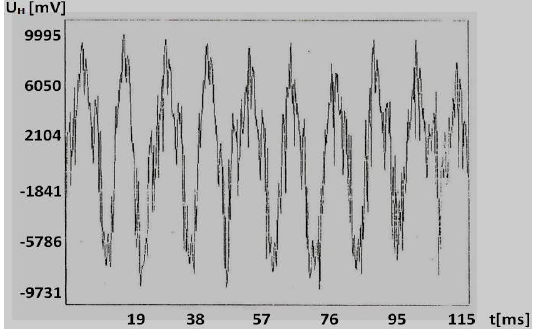
Figure 18. Hall voltage versus time in case of brush wear, Hall sensors fixed on the stator, loaded starter. The waveforms of induction distribution measured by Hall sensors fixed on the rotor and on the stator are very similar. However, the course of induction recorded by the Hall sensor fixed on the rotor provides more information useful in the analysis of starter failures in the form of a short